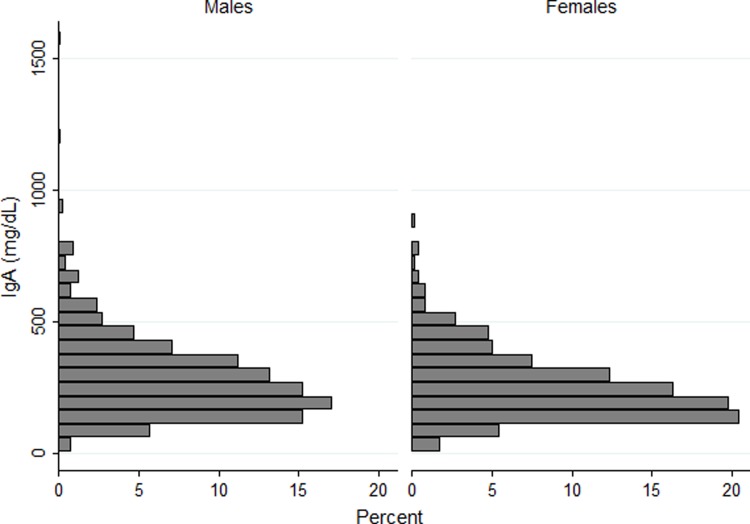
Distribution of serum IgA by gender.